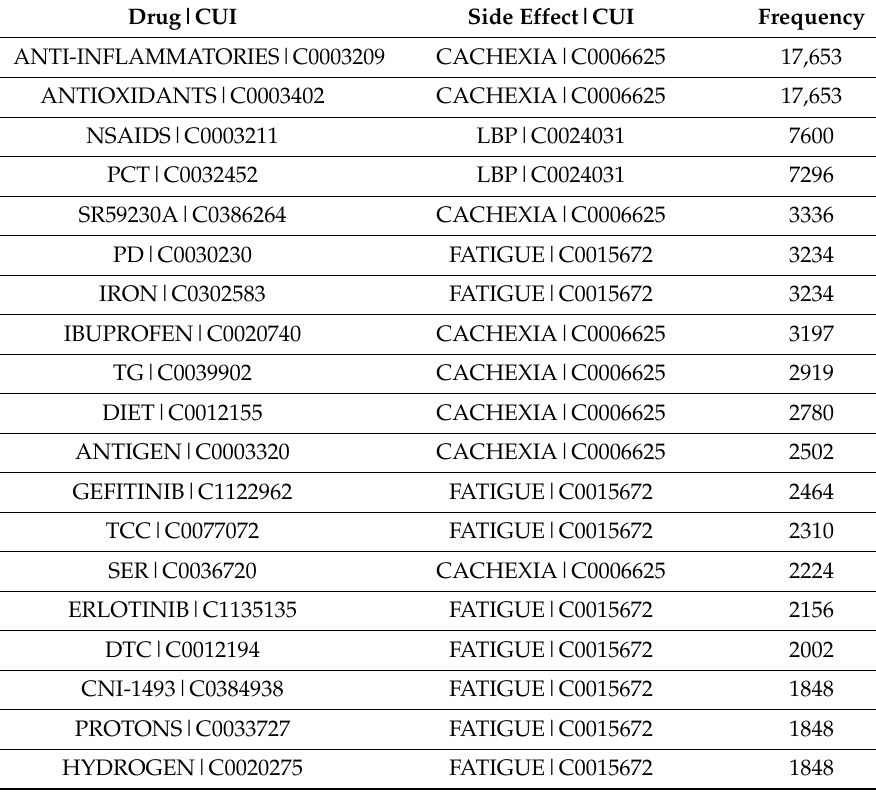
Table 8. The top 20 direct links between drug and side